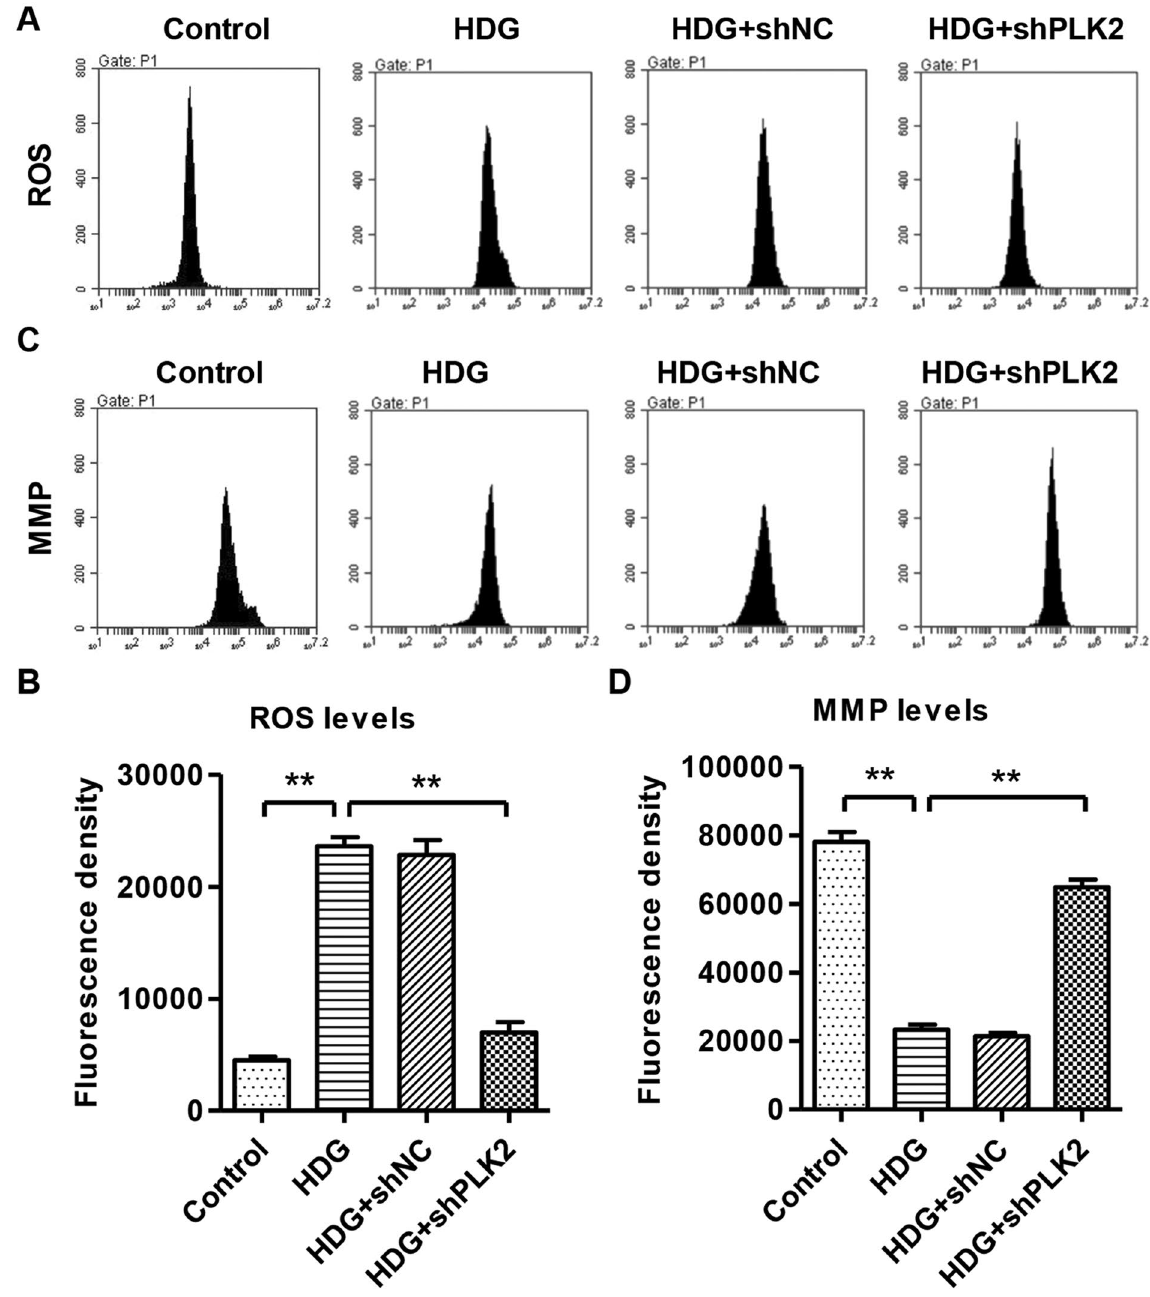
Figure 4. Knocking down PLK2 decreased ROS and increased MMP levels in mouse podocytes in response to high D-glucose (30 mM, 1 h). ( A,B ) ROS was measured by DCFH-DA fluorescent probe using flow cytometry. ( C,D ) MMP level was measured by JC-1 using flow cytometry. Suppressing PLK2 reversed HDG caused ROS accumulation and MMP decrease. ** P <